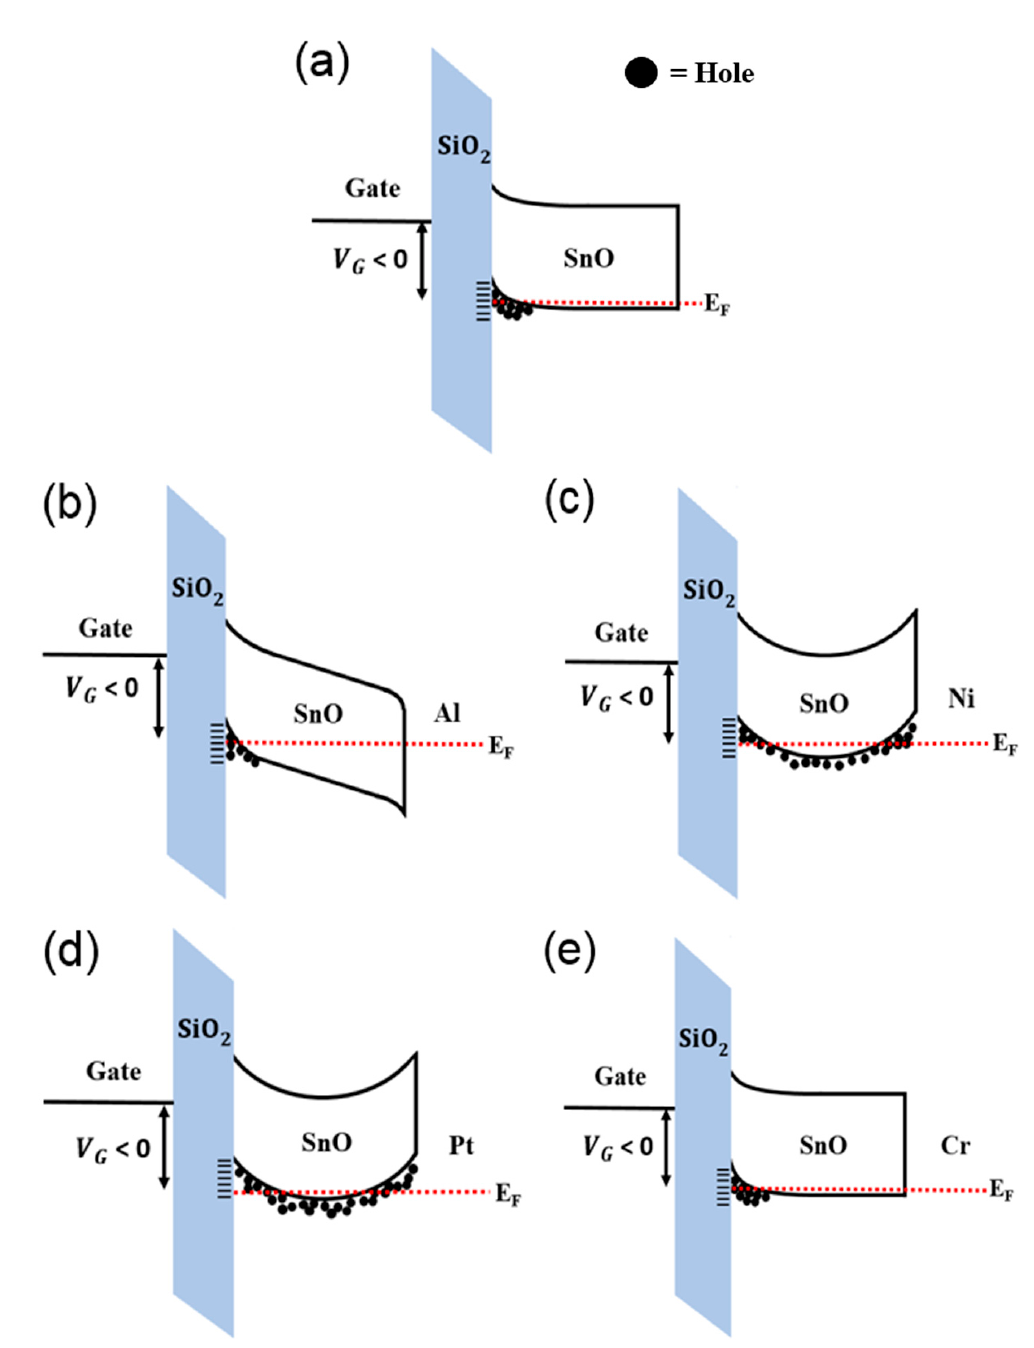
Figure 6. Energy band diagrams for ( a ) pristine, ( b ) Al-capped, ( c ) Ni-capped, ( d ) Pt-capped, and ( e ) Cr-capped SnO channels under a negative V GS at V DS = 0 V.